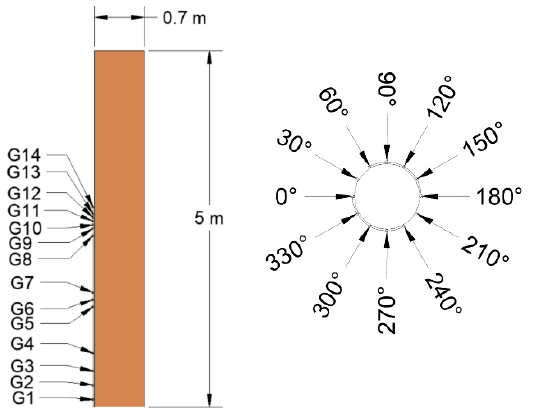
Figure 3. Schematic representation of the gauges near the substructures along the z direction every 30°.